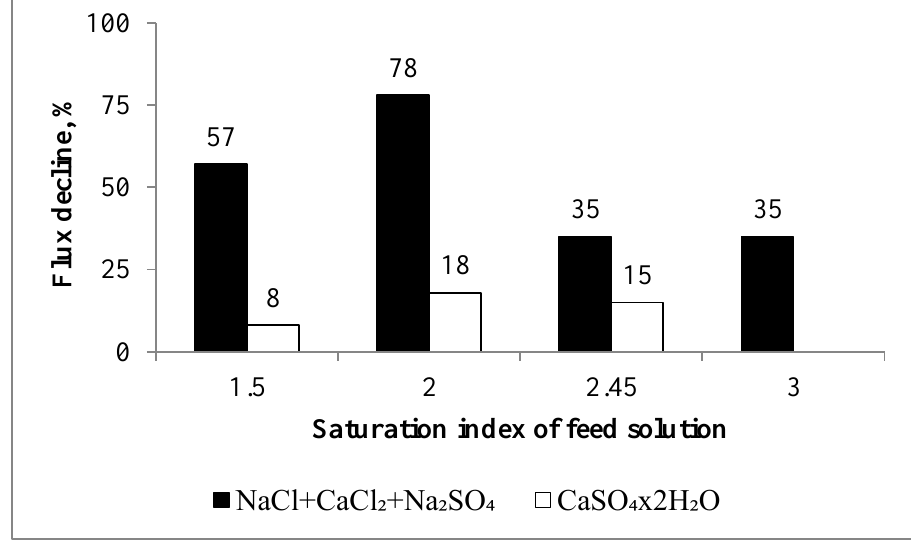
Figure 4. The decline in the flux observed for the scaling experiments: ( a ) single, binary, and ternary feed solutions; and ( b ) at different saturation indices for NaCl + CaCl 2 + Na 2 SO 4 and CaSO 4 × 2H 2 O. Experimental conditions: 12.5 cm/s cross-flow velocity; the feed and draw solutions were circulated counter-currently; and an AL-FS orientation.